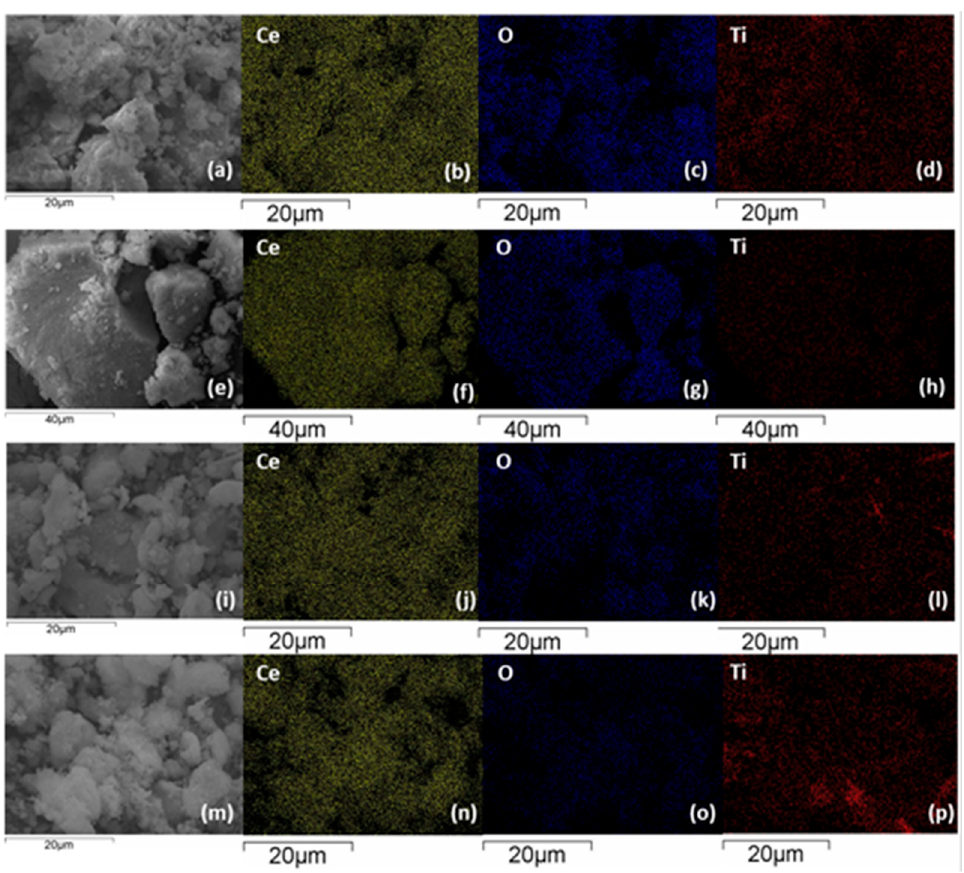
Figure 4. SEM and elemental mapping images of the samples: ( a – d ) CeO 2 / TiO 2 -P; ( e – h ) CeO 2 / TiO 2 -H1; ( i – l ) CeO 2 / TiO 2 -H2; ( m – p ) CeO 2 / TiO 2 -S.